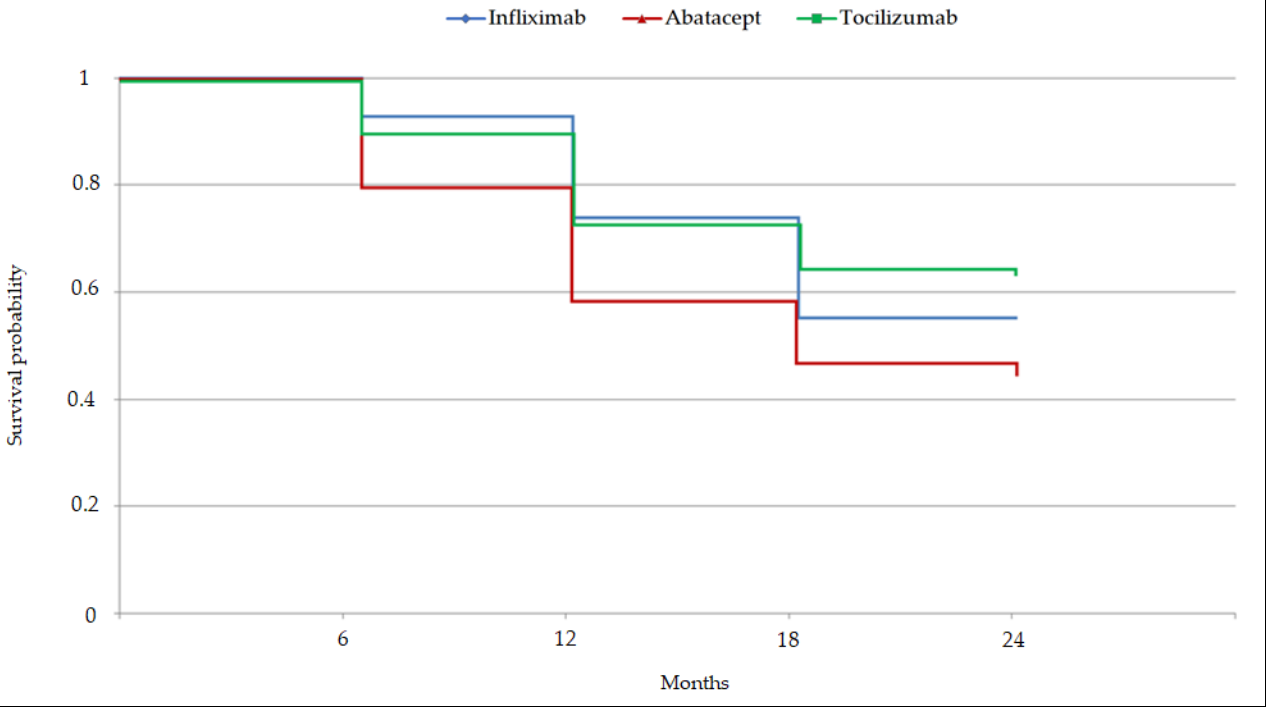
Figure 1. Kaplan – Meier estimations of the probability of bDMARD persistence at 2 years. Figure 1. Kaplan–Meier estimations of the probability of bDMARD persistence at 2 years. Table 2. Two-year drug persistence of the three bDMARDs. Table 2. Two-year drug persistence of the three